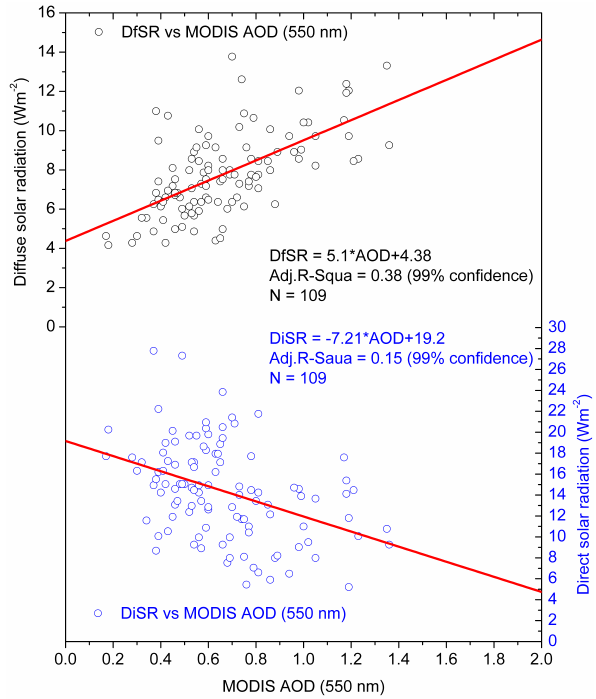
Fig. 6. Same as Fig. 3, but in